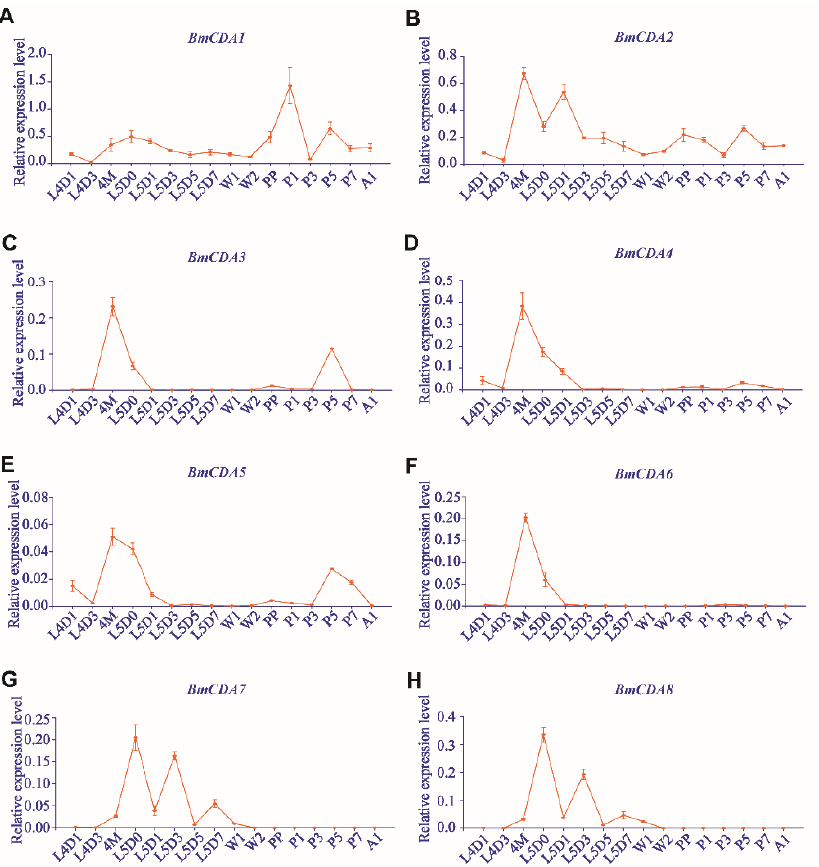
Figure 4. Expression profiles of eight chitin deacetylases ( BmCDAs ) during development in Bombyx mori . Total RNA was extracted from whole insects using day 1 of the fourth instar larvae (L4D1), day 3 of the fourth instar larvae (L4D3), molting of fourth instar larvae (4M), newly molted larvae (L5D0), day 1 of fifth instar larvae (L5D1), day 3 of fifth instar larvae (L5D3), day 5 of fifth instar larvae (L5D5), day 7 of fifth instar larvae (L5D7), day 1 of wandering (W1), day 2 of wandering (W2) prepupa (PP), day 1 of pupa (P1), day 3 of pupa (P3), day 5 of pupa (P5), day 7 of pupa (P1), and day 1 of adult (A1).